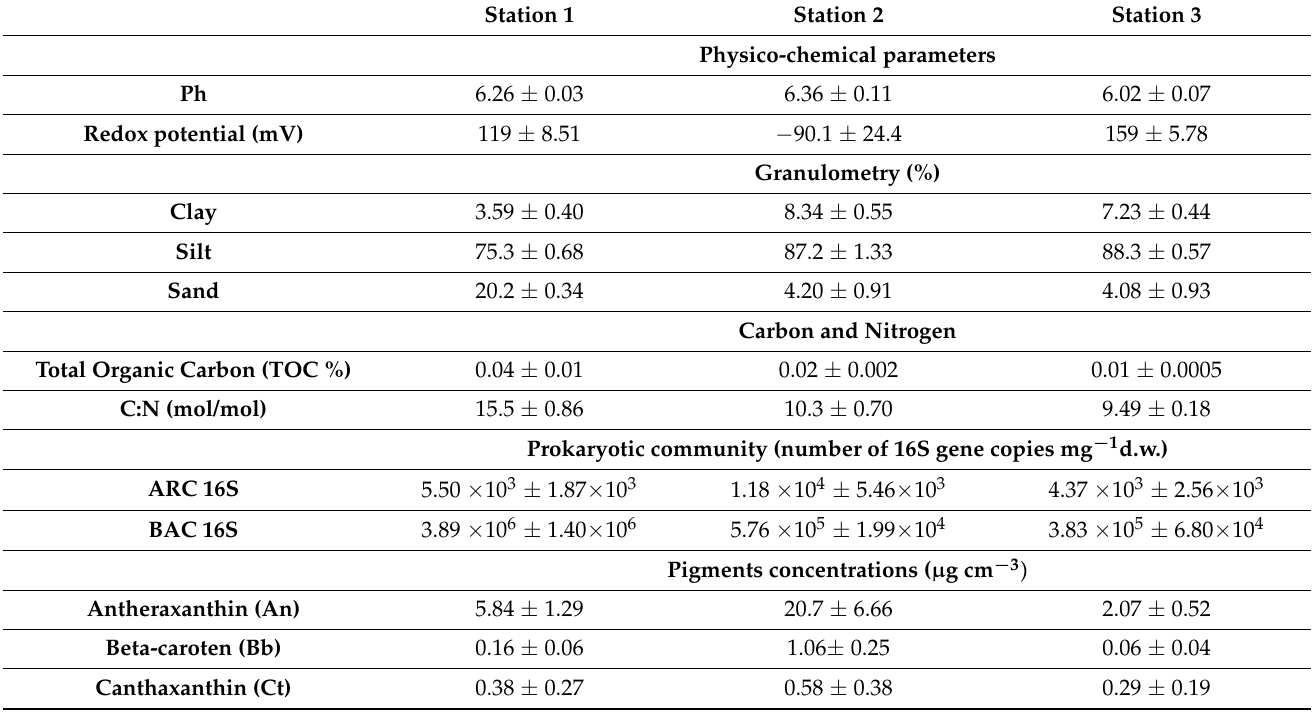
Figure 2. Multiple Factor Analysis (MFA; A ) and Between Class Analysis (BCA; B : stations distribution and C : variables distribution) with the cos² threshold of 0.4: Distribution of physical, chemical, and biological parameters at each station (purple: Physico-chemical parameters; black: Organic contaminants and metals; red: Prokaryotic biomass; green: Organic matter; blue: Pigments). BCA-ratio: Part of total inertia explained by the sampling sites. Table 1. Mean values of the three cores over the entire sedimentary column from each station for the physical, chemical, and biological parameters (mean ± SD; n =